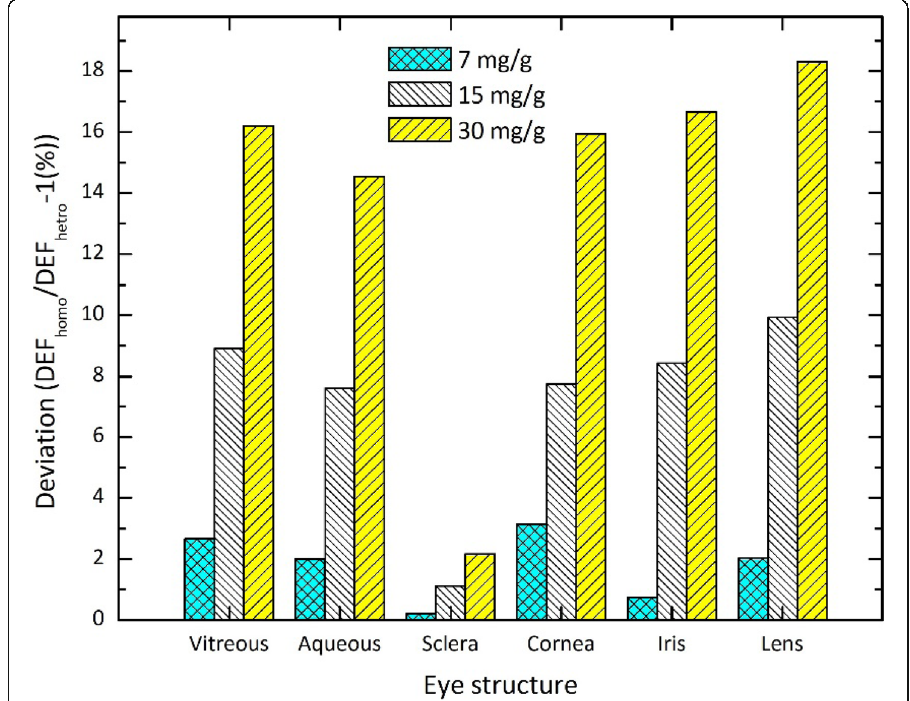
Fig. 8. The deviation from DEF in the heterogeneous model (DEF hetro ) of DEF in the homogeneous model (DEF homo ) for various eye structures. These data correspond to the presence of 50 nm GNPs with concentrations of 7, 15, and 30 mg/g in the